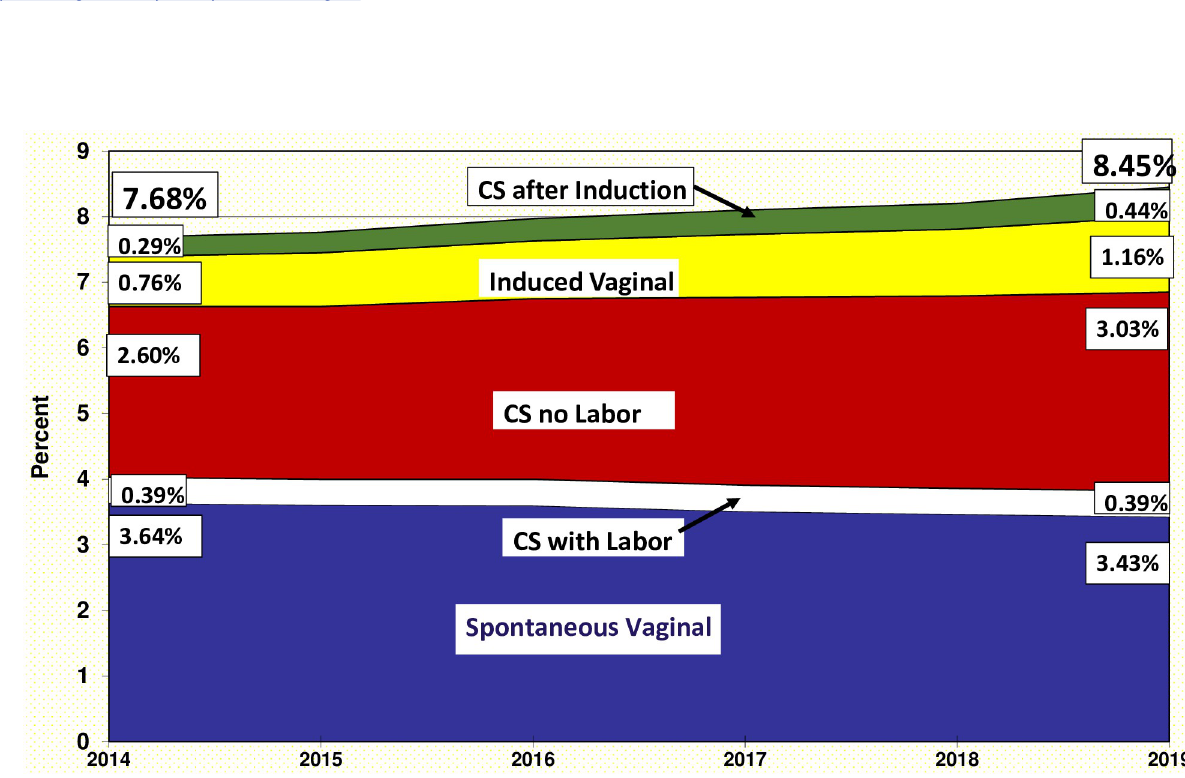
PLOS ONE | https://doi.org/10.1371/journal.pone.0265146 March 30,